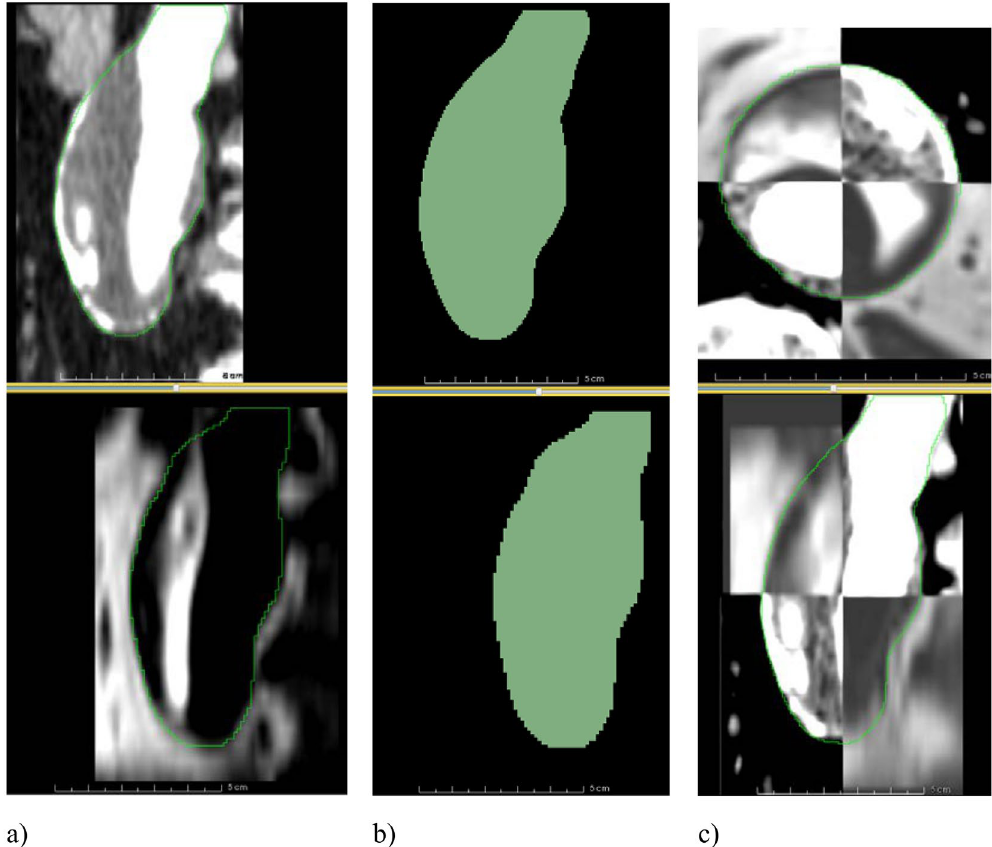
Figure 10. MRI to CT registration. ( a ) A sagittal slice of an AAA in a contrast-enhanced CT image (top) and the corresponding slice in the MR image (bottom). The contours of the AAA segmentations are shown in green. The two images occupy different positions in space and need to be registered. ( b ) The segmentations of the CT (top) and MR (bottom) images. The two label maps are registered and the resulting transform is saved. ( c ) The transform obtained from the label map registration is used to register the MRI dataset to the CT dataset. A checkerboard display of the two images is used to verify the registration result in axial (top) and sagittal (bottom) views, with the contour of the AAA segmentation shown in